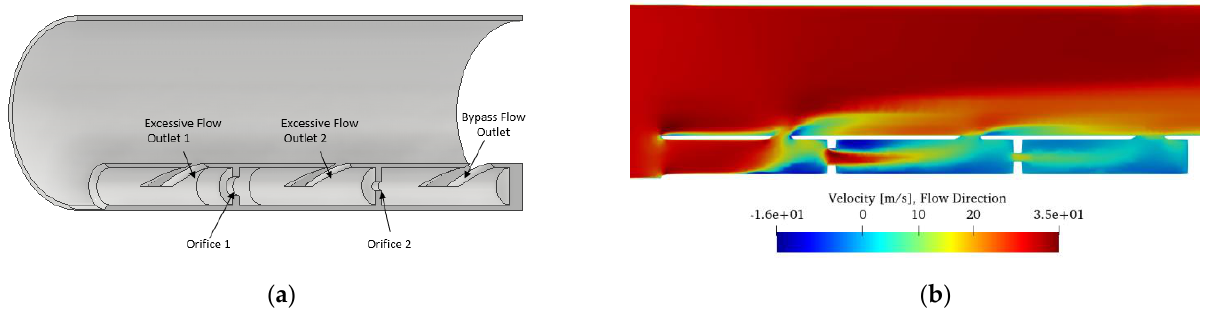
Figure 3. ( a ) Test design concept (1) 3D, mid-section; ( b ) rest design concept (1) simulation result.